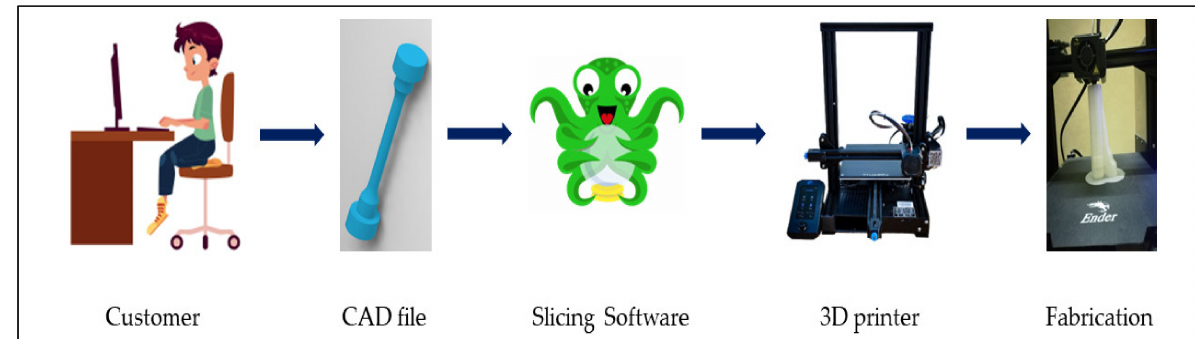
Figure 4. Conventional 3D printing workflow.